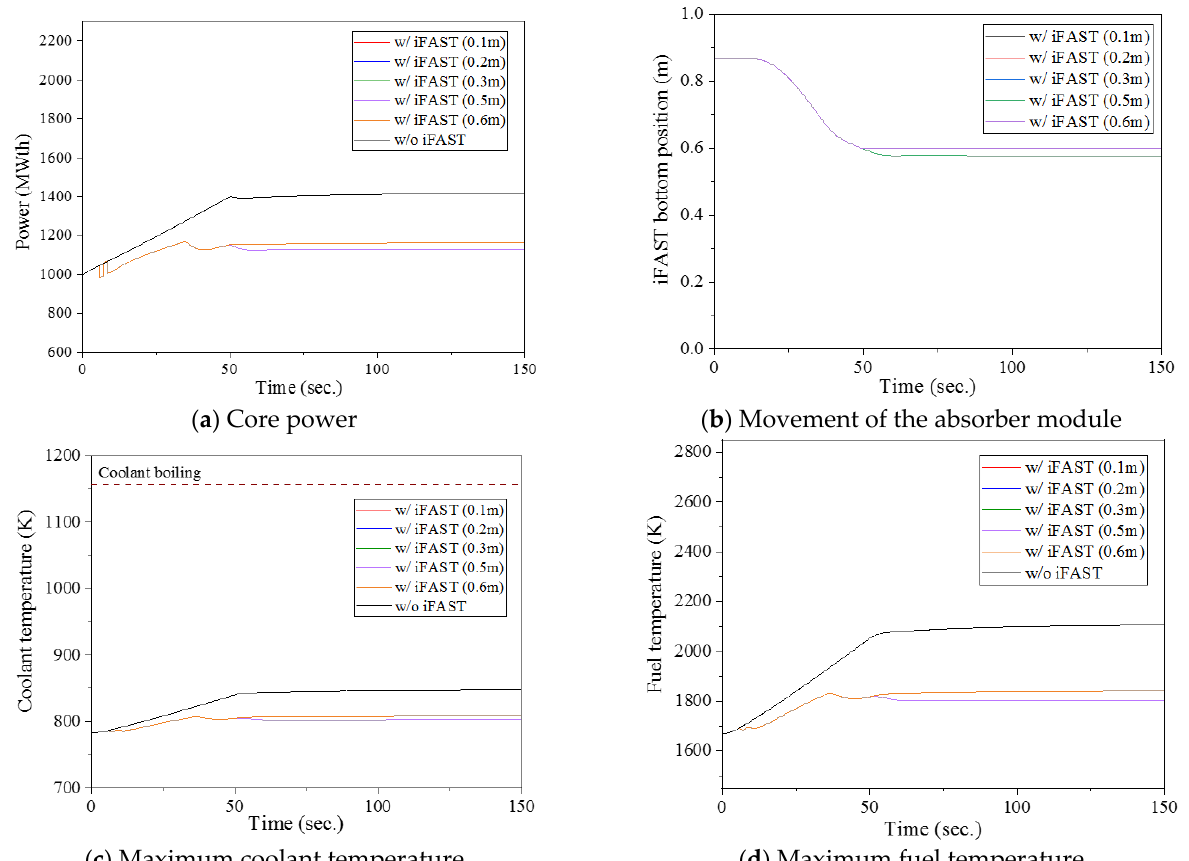
Figure 9. Unprotected transient over power (0.4$/50 s) with constant inlet temperature in IHX and 1.8$ maximum iFAST worth